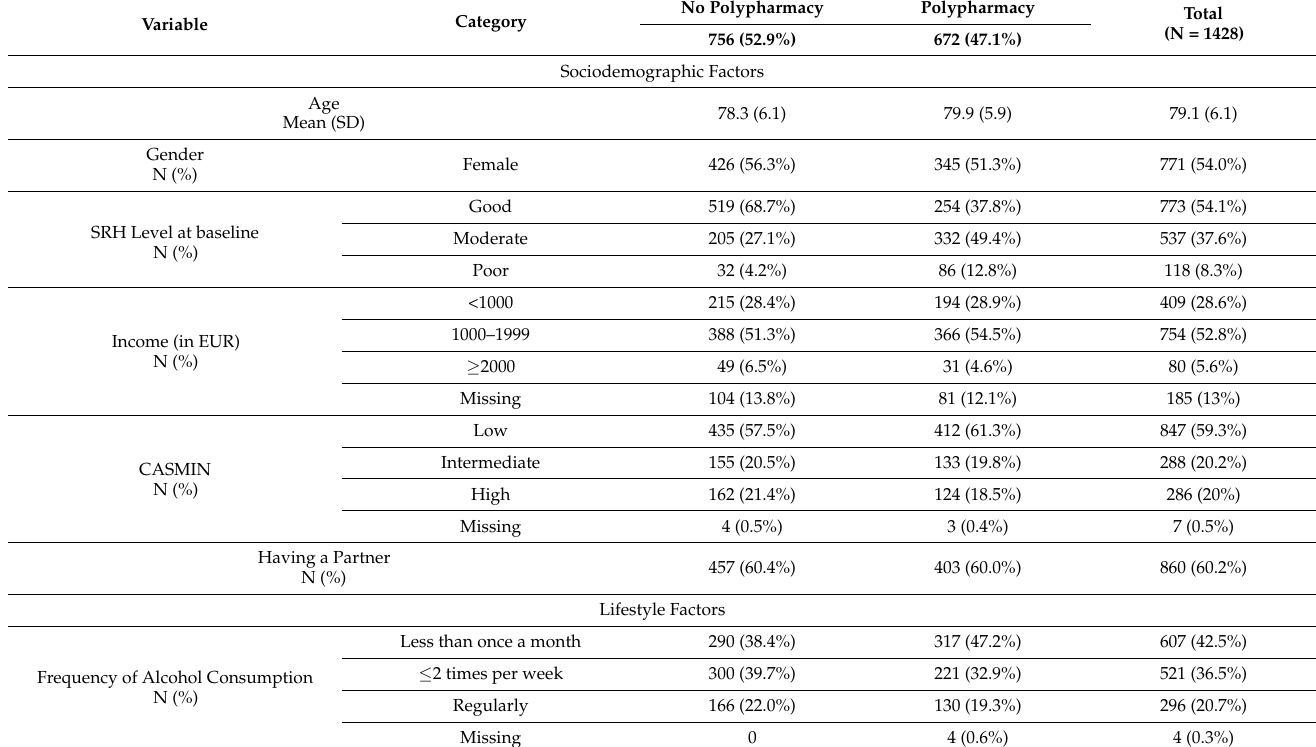
Table 1. Main characteristics of the study population by polypharmacy